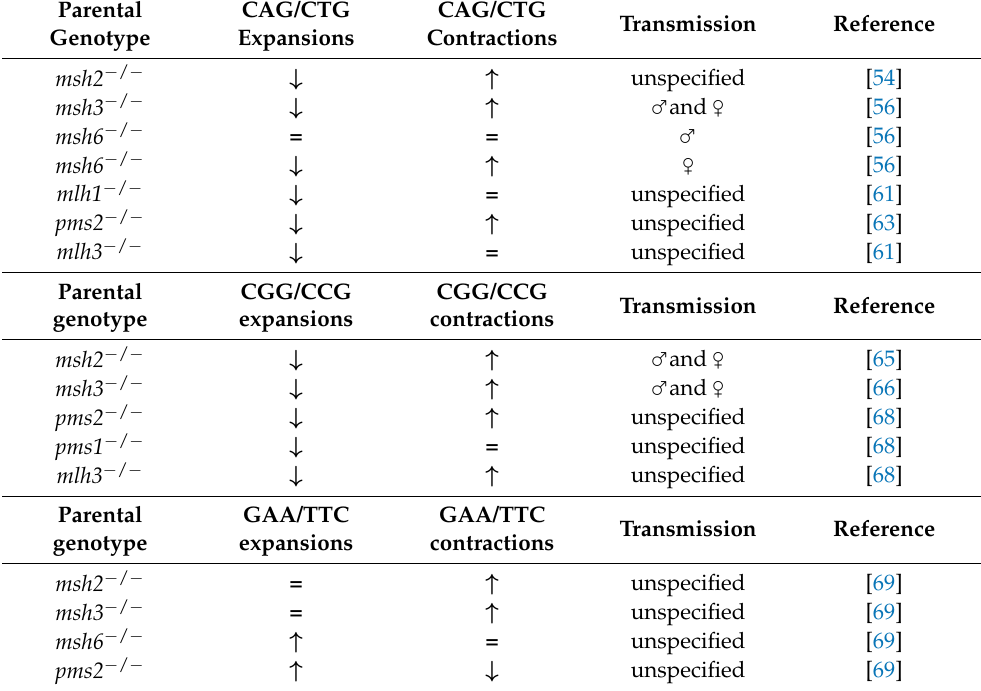
Table 2. Effect of mismatch repair mutations on trinucleotide repeat instability, compared to wild-type transgenic